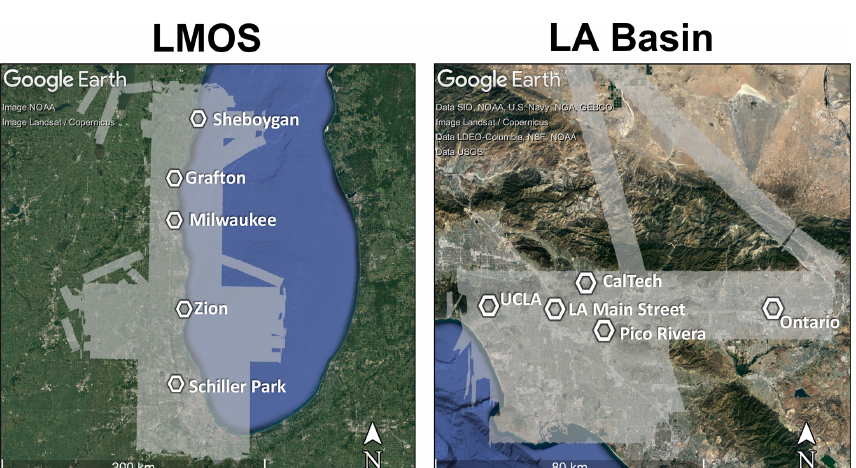
Figure 1. Maps of the LMOS and LA Basin regions showing the areas mapped by GeoTASO during summer 2017. The labeled hexagons indicate locations of Pandora spectrometers operating during the flight days. Base map created in ©Google Earth